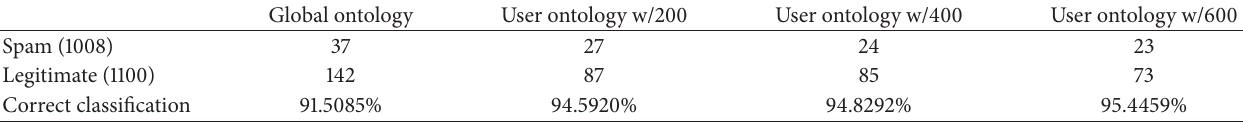
Table 9: Results of SPONGY system.